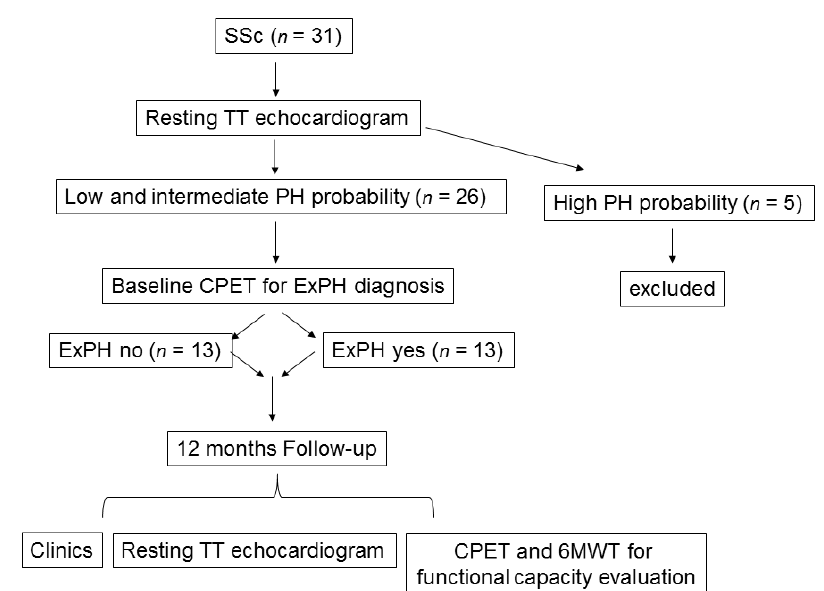
Figure 1. Study flowchart illustrating the study from enrollment to end of follow-up. Legend: CPET: cardiopulmonary exercise test; ExPH: exercise-induced pulmonary hypertension; PH: pulmonary hypertension; SSc: scleroderma; TT: transthoracic; 6MWT: six-minute walking